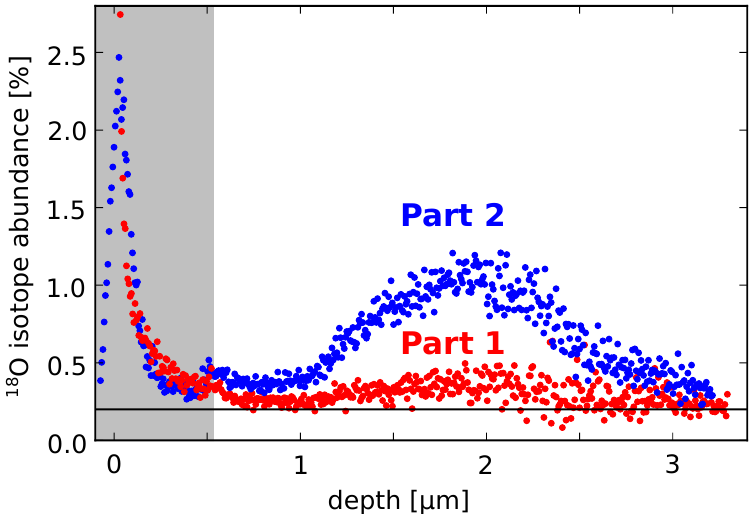
Figure 5. Part 1: 18 O isotope abundance after oxidation of W-12Cr-0.6Y at 1273K for 65min in Ar + 16 O 2 atmosphere followed by 11min with increased 18 O abundance. Part 2: continued oxidation of the sample from part 1 at 1273K for 20min in Ar + 16 O 2 atmosphere. The depth to which the Cr 2 O 3 layer extends is marked in gray. The natural abundance of 0.2% 18 O is marked by the black line